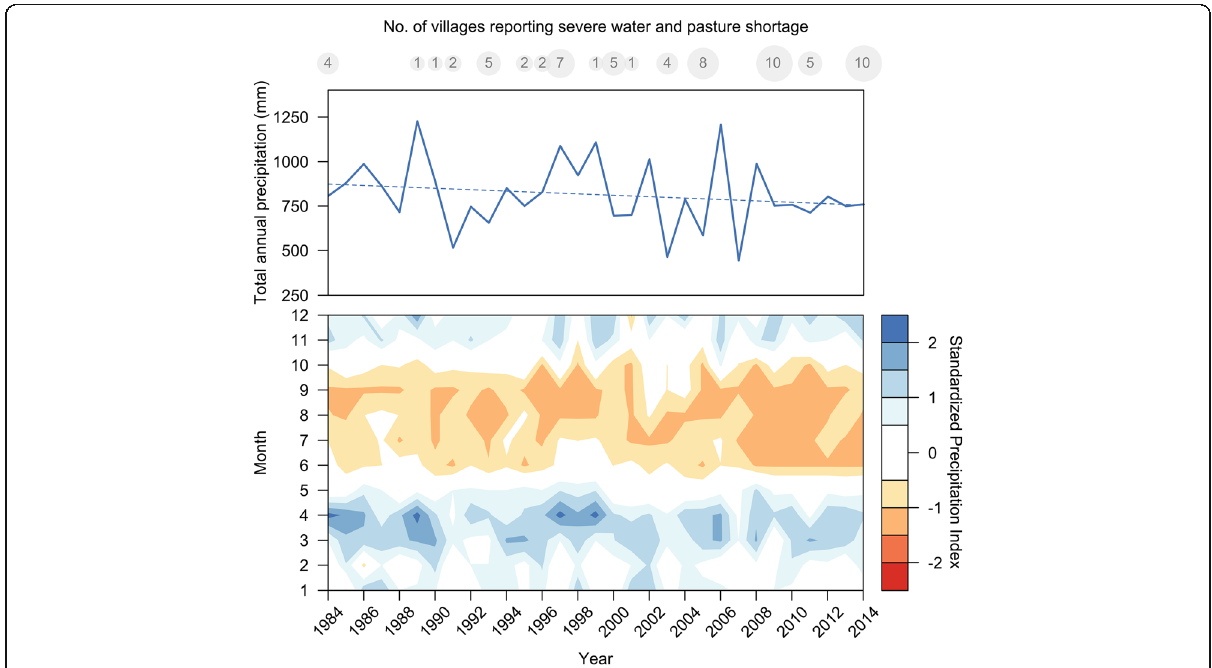
Figure 2 Total annual precipitation and Standardized Precipitation Index (SPI) for Monduli District, Northern Tanzania (1984 – 2014). Linear trend for rainfall is shown as a blue dashed line. SPI reflects the number of standard deviations from the long-term trend, with blue, white and orange reflecting moist, near normal, and dry periods, respectively. Drought periods are represented by relatively high negative deviations (SPI ≤ − 1.0). For contrast, years recalled by pastoralists as having severe water and pasture shortage are shown as gray bubbles. The size of the bubble corresponds to the number of villages that reported this outcome in a particular year (range: 0 –